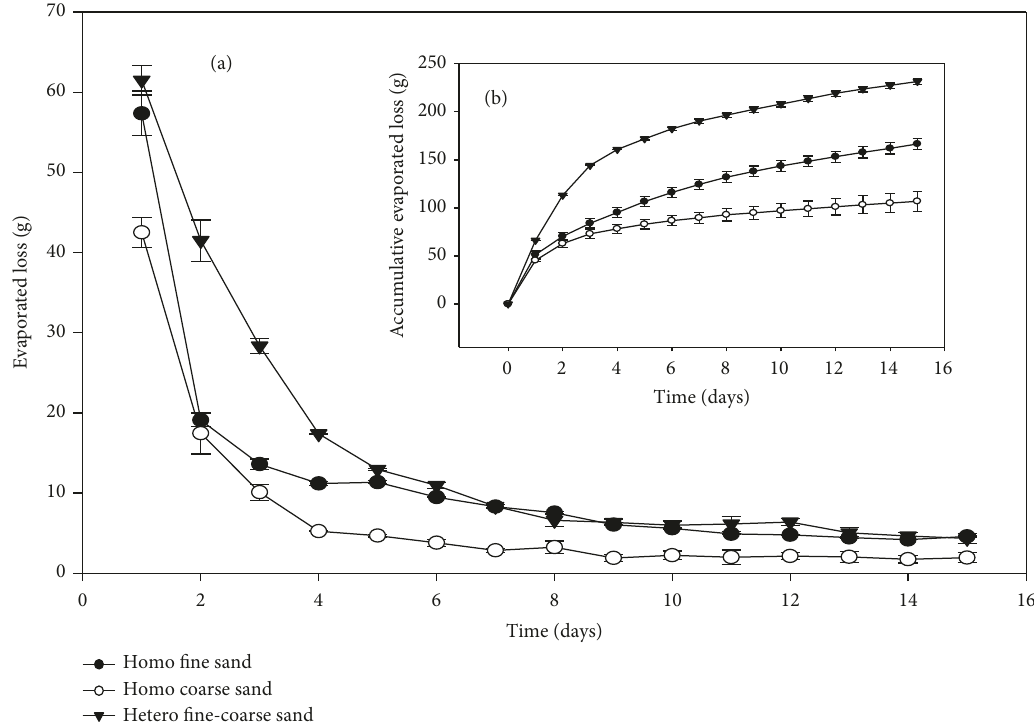
Figure 4: Dynamic variation of evaporation loss with time for three treatments: (a) evaporative loss with time; (b) accumulative evaporated loss.